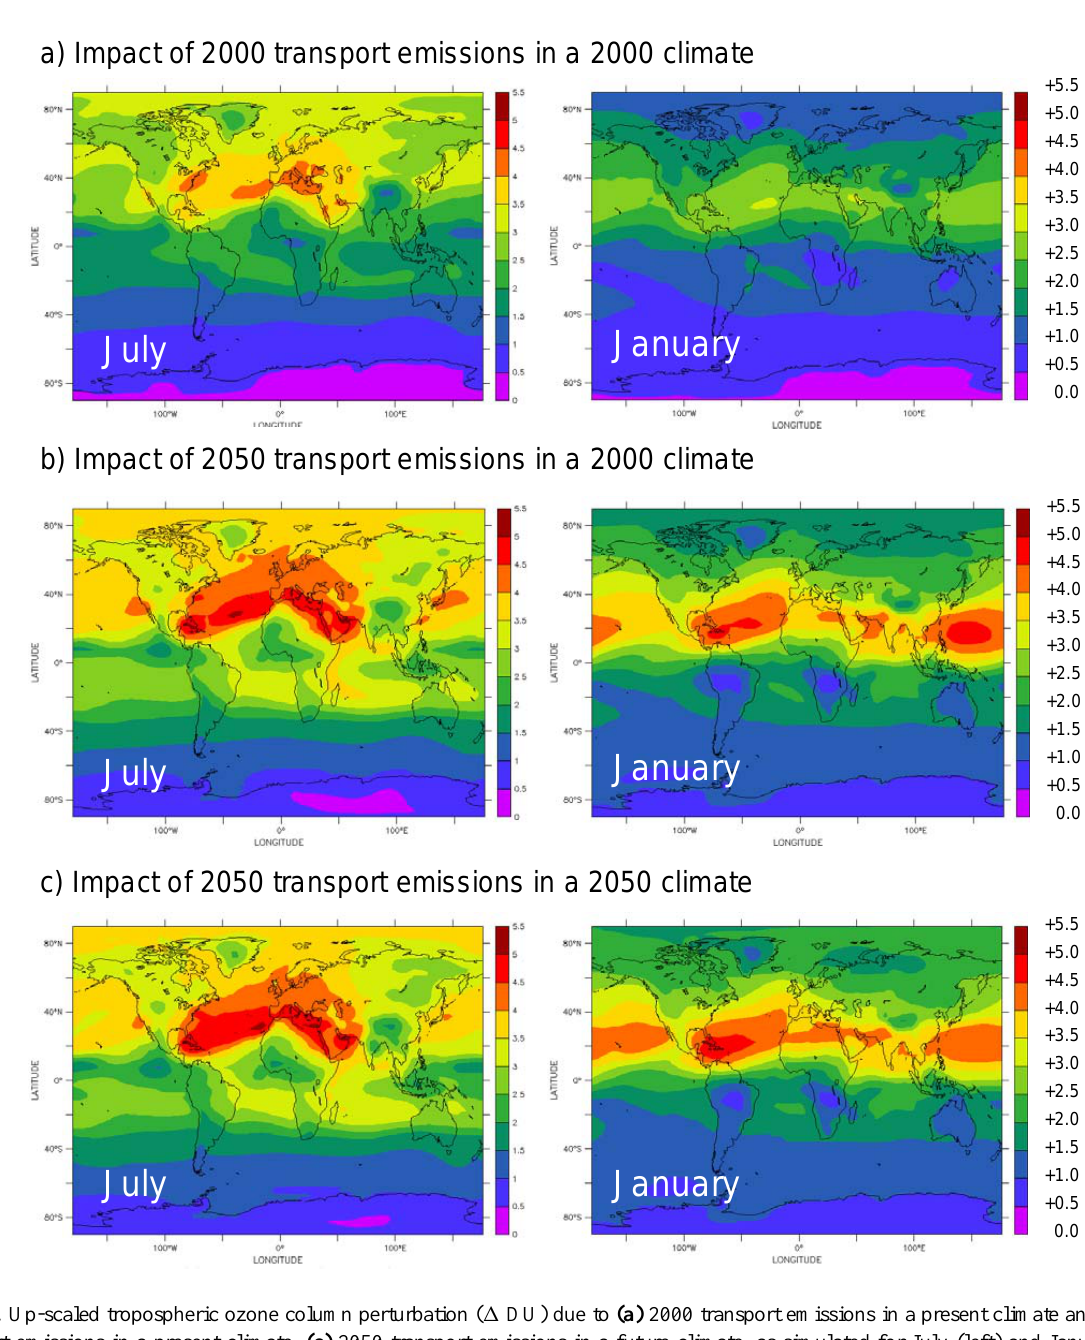
Fig. 10. Up-scaled tropospheric ozone column perturbation ( 1 DU) due to (a) 2000 transport emissions in a present climate and (b) 2050 transport emissions in a present climate, (c) 2050 transport emissions in a future climate, as simulated for July (left) and January (right) conditions (A1B emission